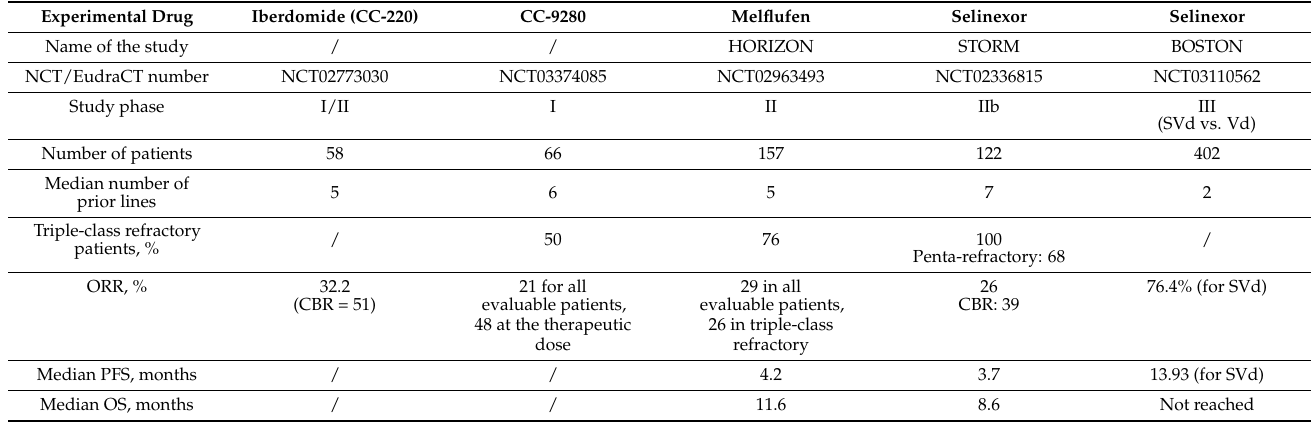
Table 1. Available results of the different trials that investigated novel non-immunologic drugs for patients with relapsed or refractory multiple myeloma.